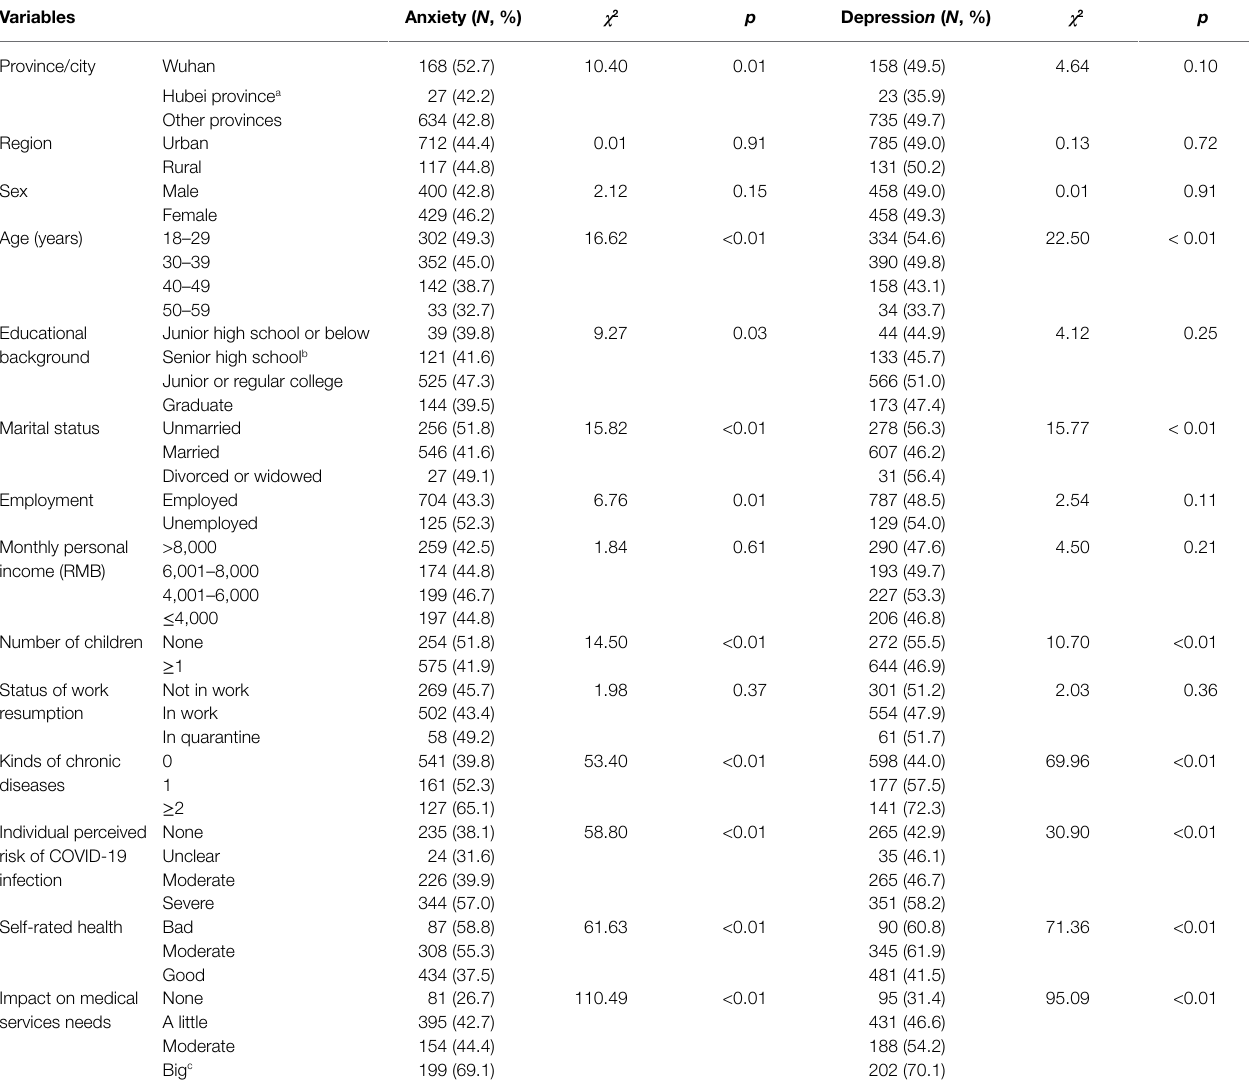
TABLE 3 | Univariate analysis of anxiety and depression of the adult, working-age population in Mainland China in the COVID-19 pandemic.